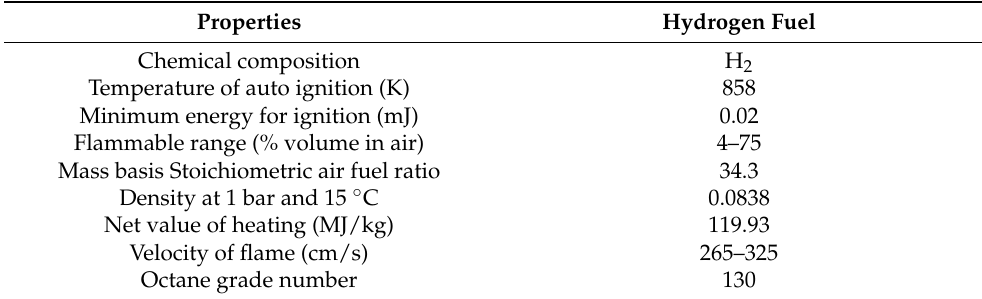
Table 2. Properties of H 2 [12] (adapted with permission from International Journal of Hydrogen